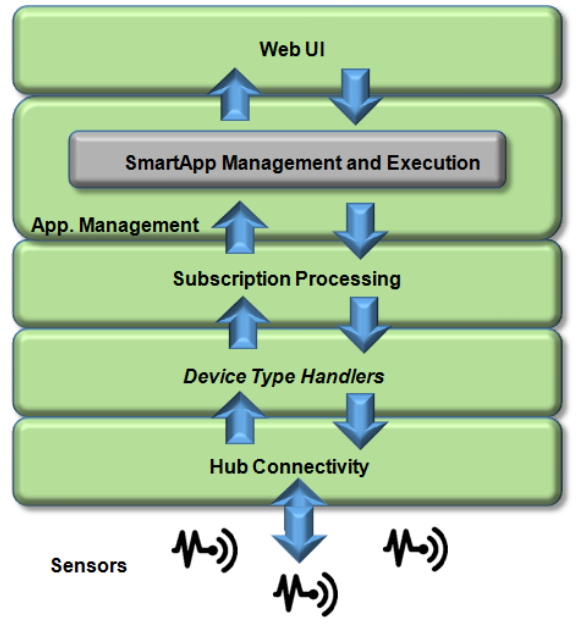
Figure 26. Illustration of the SmartThings